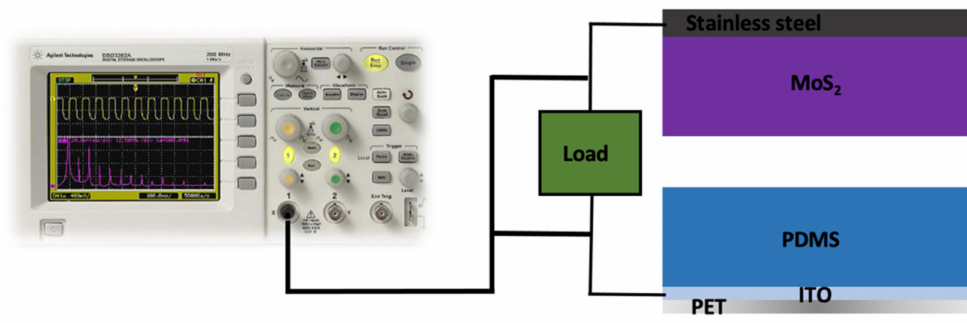
Figure 2. Schematic view of the experimental setup to measure the electrical response of the triboelectric energy harvester.